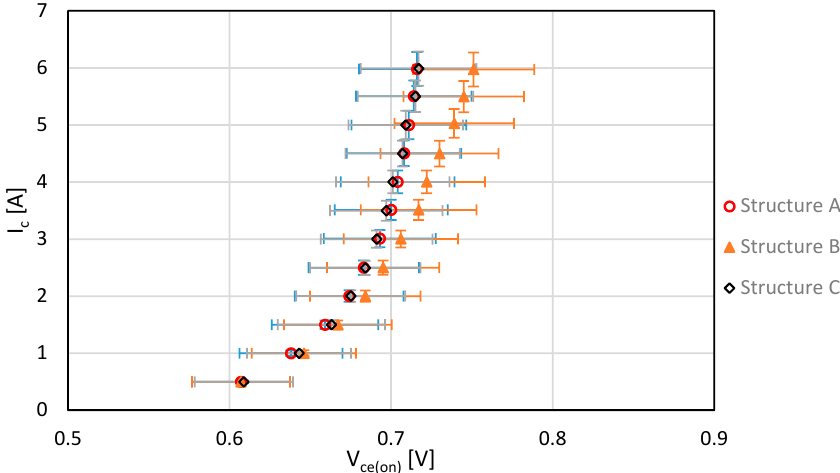
Figure 5. Measured device output characteristics of the three structures.